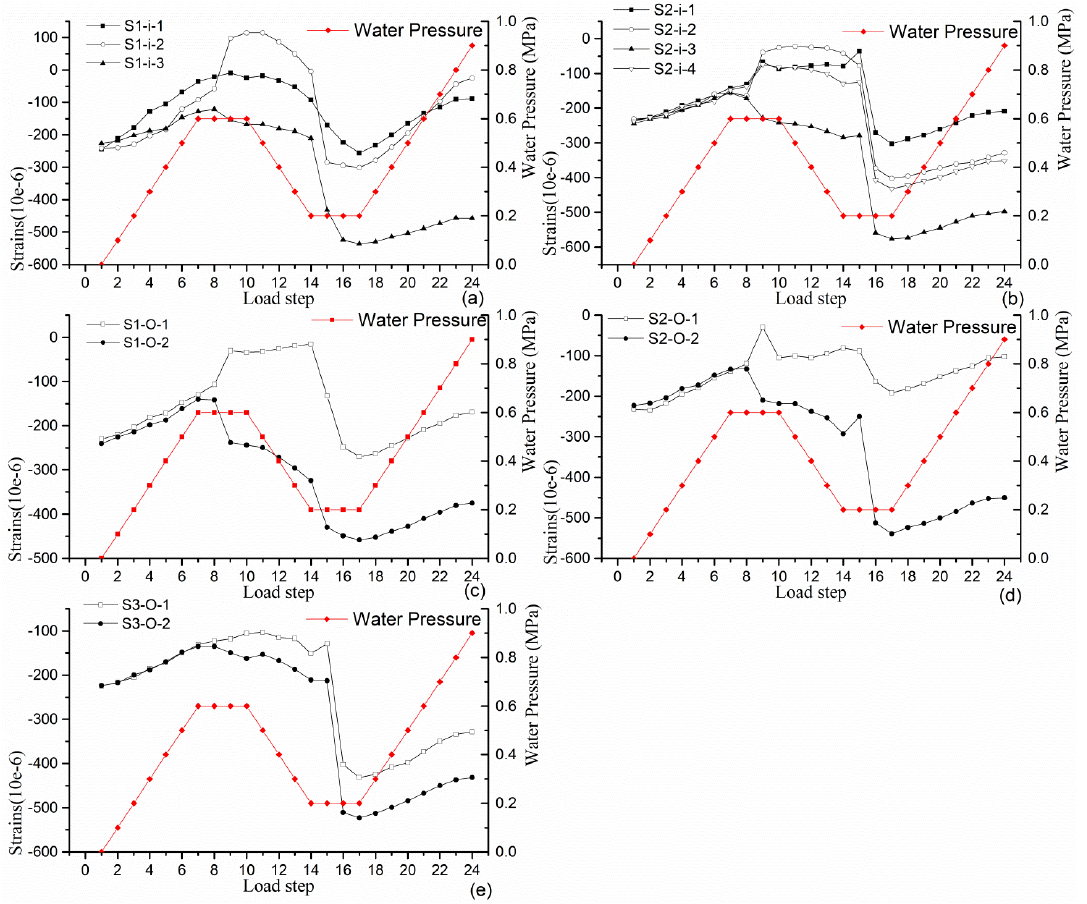
Figure 15. The strain curves of core concrete: ( a ) Section 1 of inner concrete core; ( b ) Section 2 of inner concrete core; ( c ) Section 1 of outer concrete core; ( d ) Section 2 of outer concrete core; ( e ) Section 3 of outer concrete